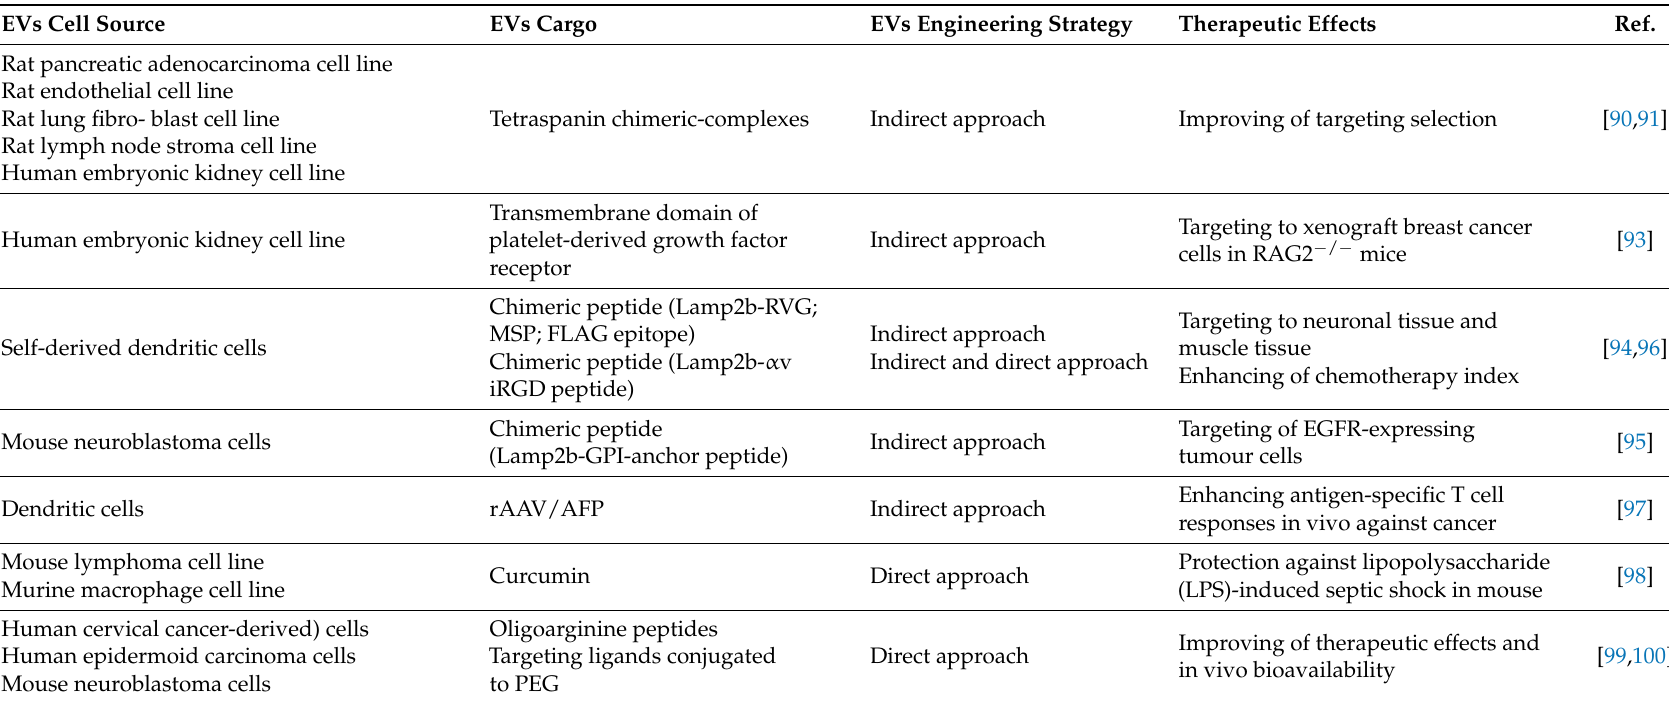
Table 1. Experimental studies on EVs modification: Bioactivity and therapeutic